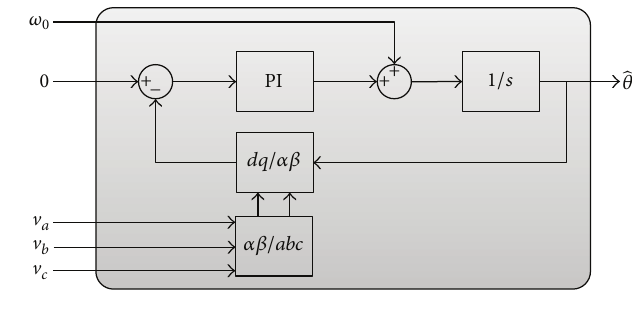
Figure 6: SRF-PLL scheme.